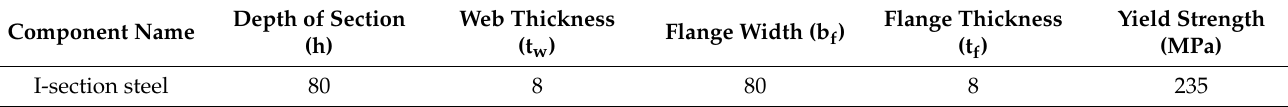
Figure 7. Weld-connected I-shaped steel section and trapezoidal steel plate. Table 1. I-shaped steel section size (mm).